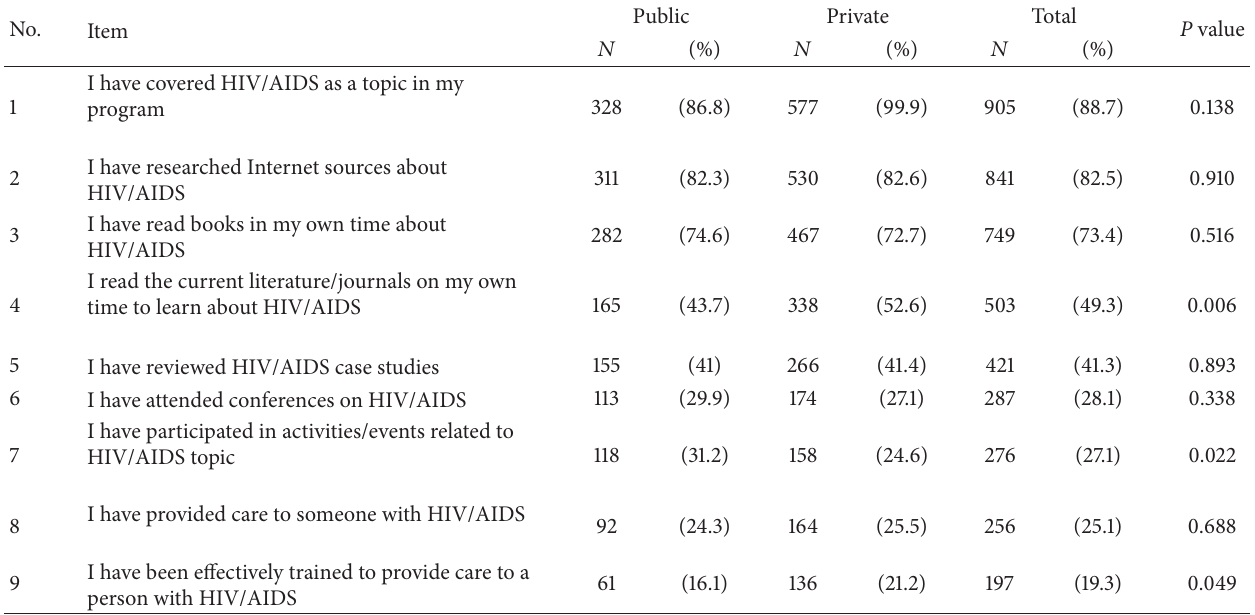
Table 2: Training related to HIV/AIDS received by survey respondents ( 𝑁 = 1020